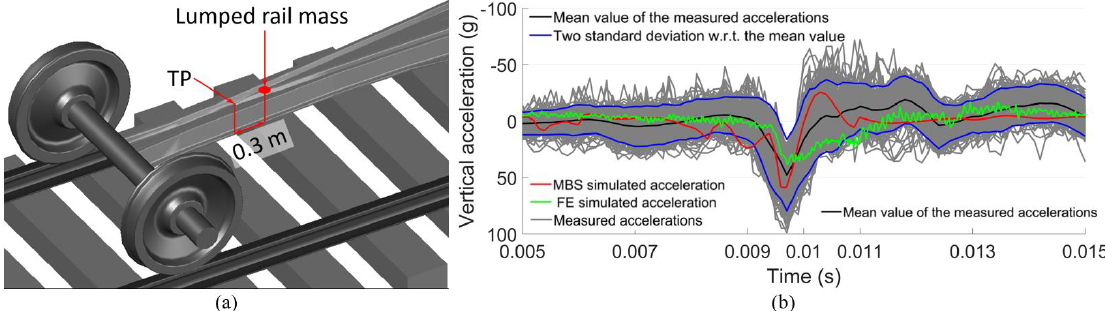
Figure 16. (a) Rail element for acceleration extraction in the MBS model. (b) Comparison of simulated accelerations with measured ones in time domain.